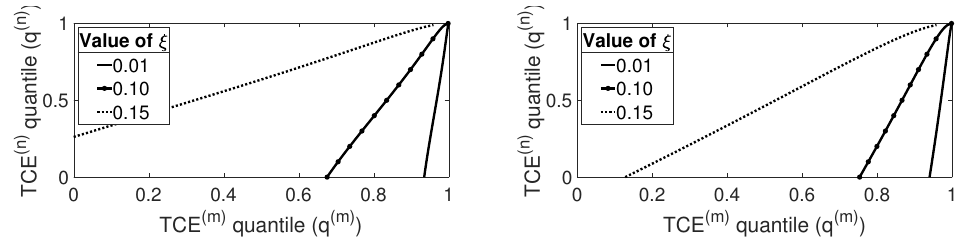
Figure 9. Extended TCE quantile at order n = 2 as a function of extended TCE quantile at order m = 5 with σ = 0.1. ( Left panel ): µ = − 0.05. ( Right panel ): µ = + 0.05.